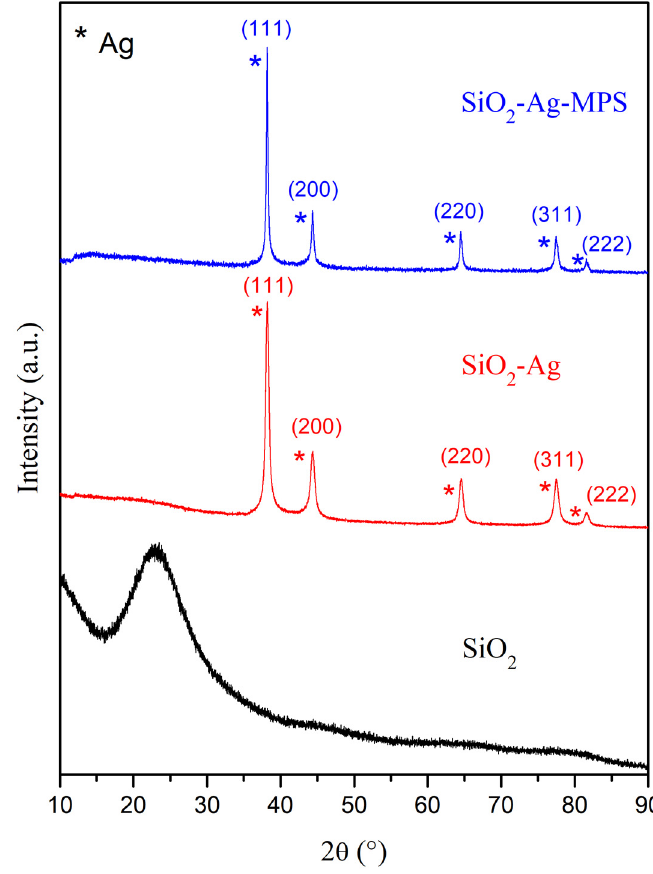
Figure 3. XRD analysis of SiO 2 , SiO 2 -Ag, and SiO 2 -Ag-MPS nanoparticles. The peaks highlighted by the asterisk (*) refer to the metallic silver (Ag).